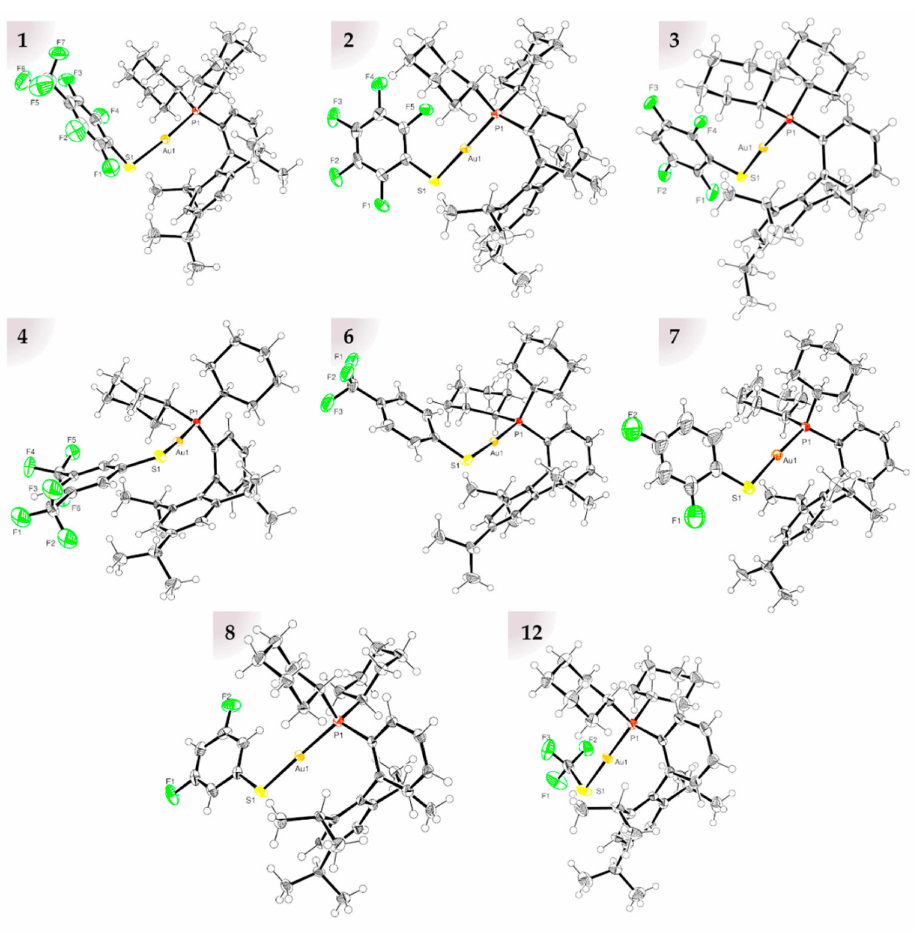
Figure 1. ORTEP diagrams at 50% probability level of the molecular arrangements determined by monocrystal X-ray diffraction for compounds 1 – 4 , 6 – 8 , and 12 . The conformers of 7 and 12 are shown in Figure S1. Table 1. Selected distances and angles from the crystal X-ray structures of compounds 1 – 4 , 6 – 8 , and 12 . The full set of crystallographic distances and angles are available in the Supplementary Materials.